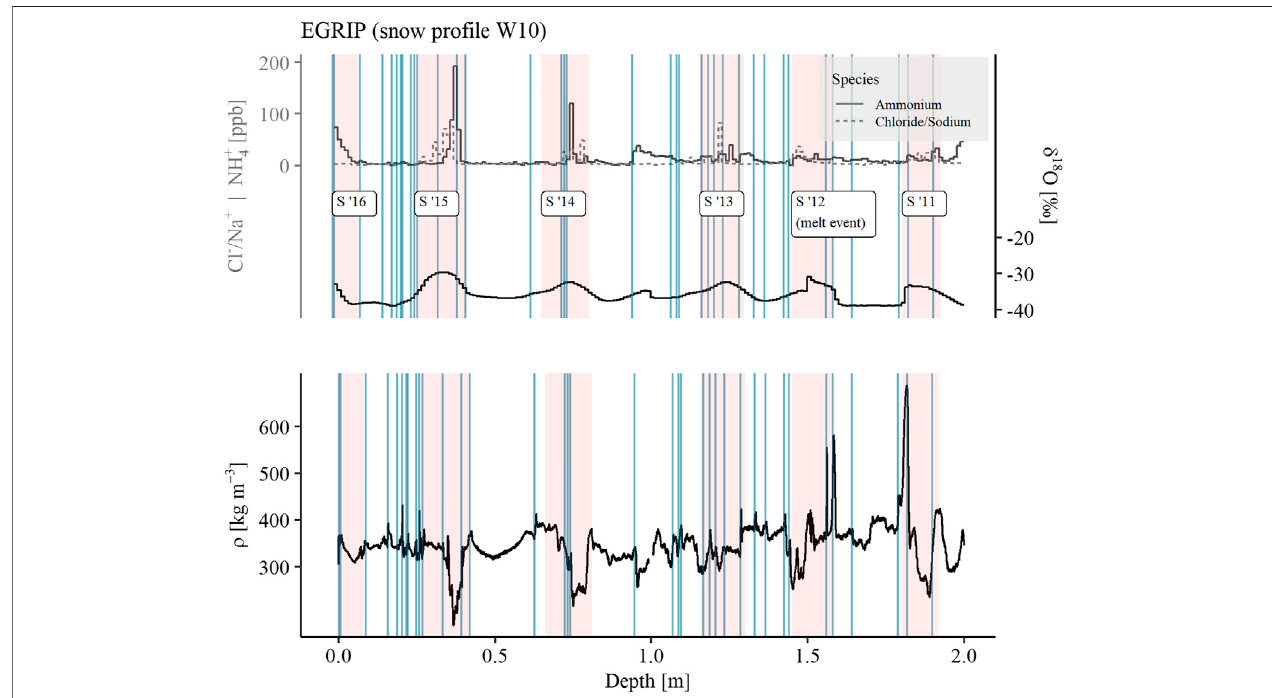
FIGURE 9 | Snow pro fi le from the trench at EGRIP (W10), sampled in May 2016. Five clear annual cycles are visible in Cl − /Na + (dotted gray) and NH 4+ (solid gray). Crusts are indicated with blue vertical lines. Interpreted summer signals are marked with a red shade, the corresponding year of summer (S ’ yy) is annotated in the top panel. Below 1.4 m depth the pro fi le is in fl uenced by surface melting (2012) and percolating melt water (e.g. Nghiem et al., 2012).